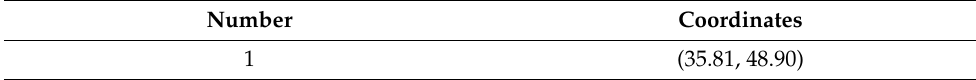
Table 6. Distribution center information.